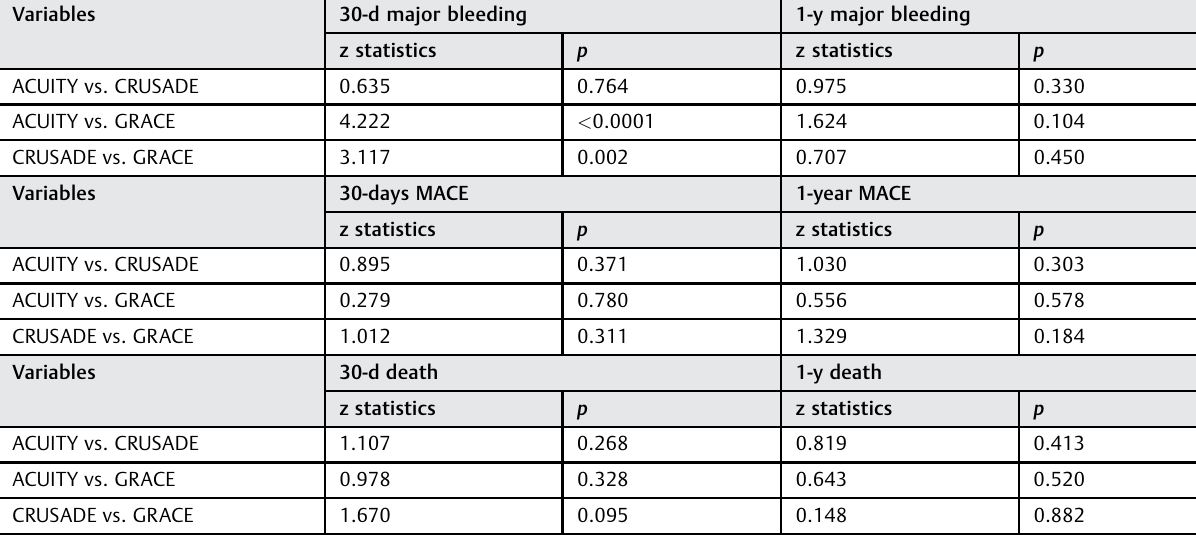
Table 3 Discrimination of ACUITY versus CRUSADE versus GRACE for predicting outcomes Variables